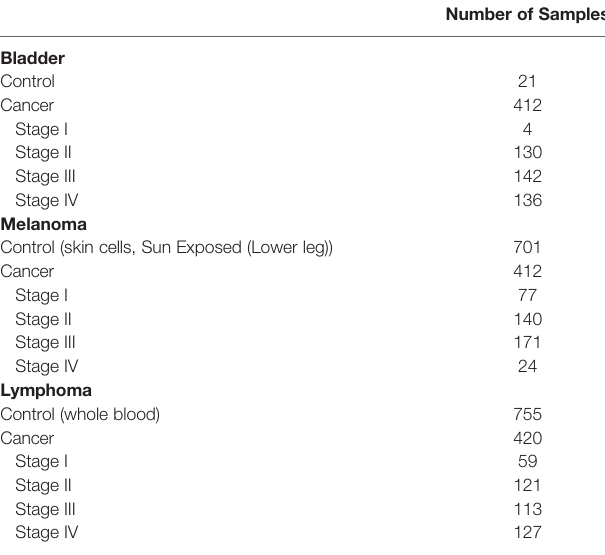
TABLE 1 | Number of human cancer samples for CD49b and CD29 gene expression analysis.